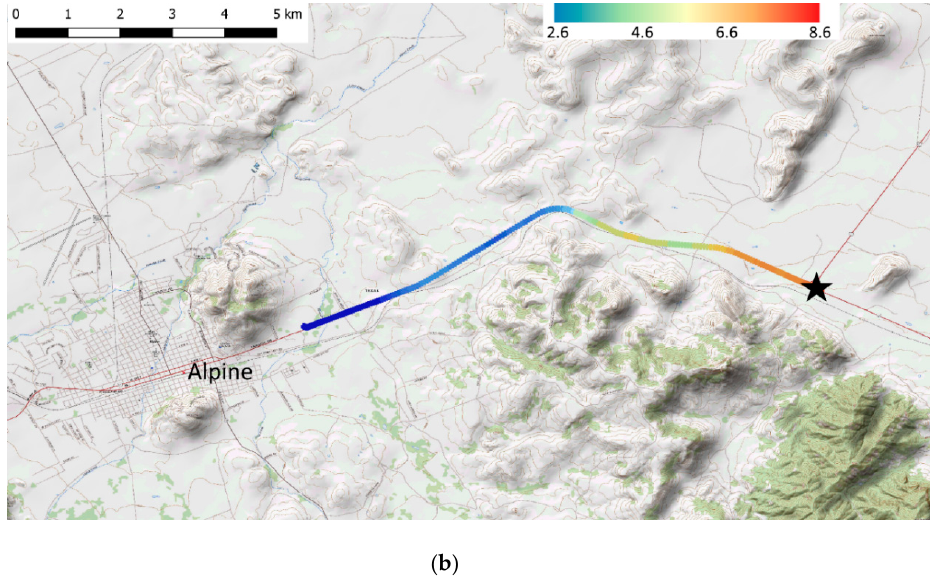
Figure 8. ( a ) Isopleths of mixing ratio (g/kg) on the westward transect near Alpine in relation to 0300 UTC station observations and topographic features. ( b ) Relation of the mixing ratio to topographic features on the eastward transect. Windsond launch site is indicated by star.